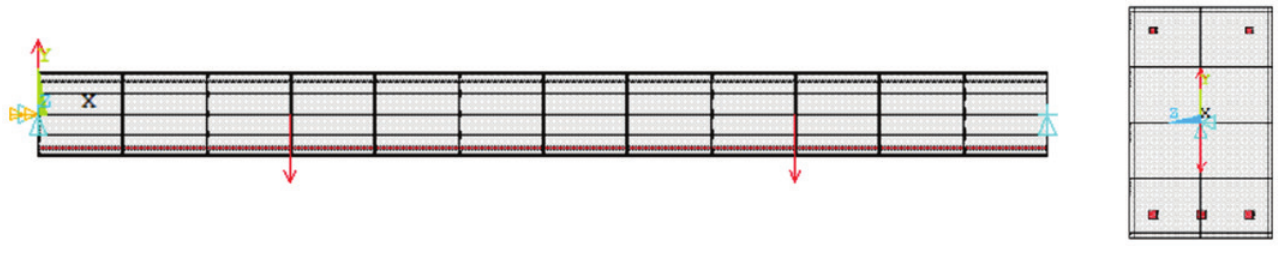
Finite element mesh used for analysis and validation of the numerical